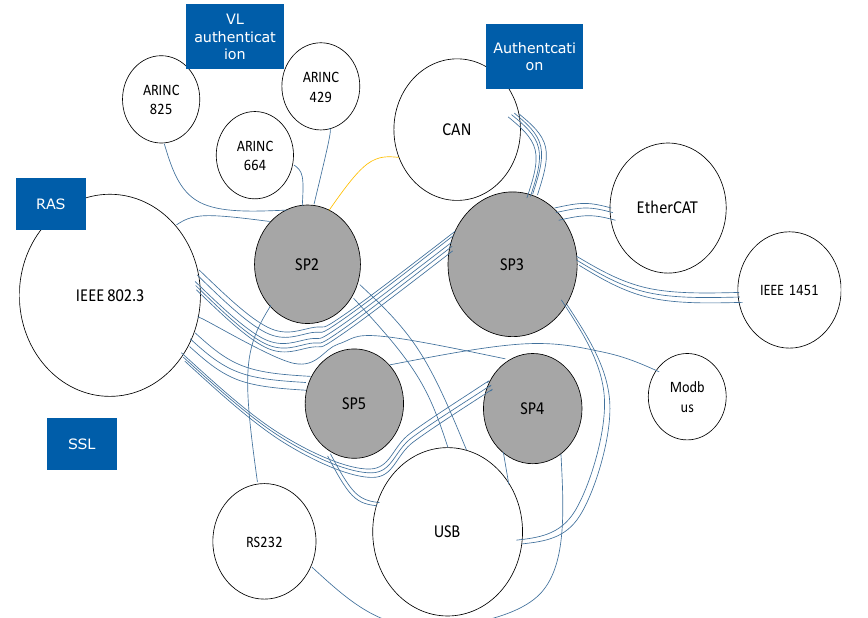
Figure 10. COTS standards L1 wireline technologies.